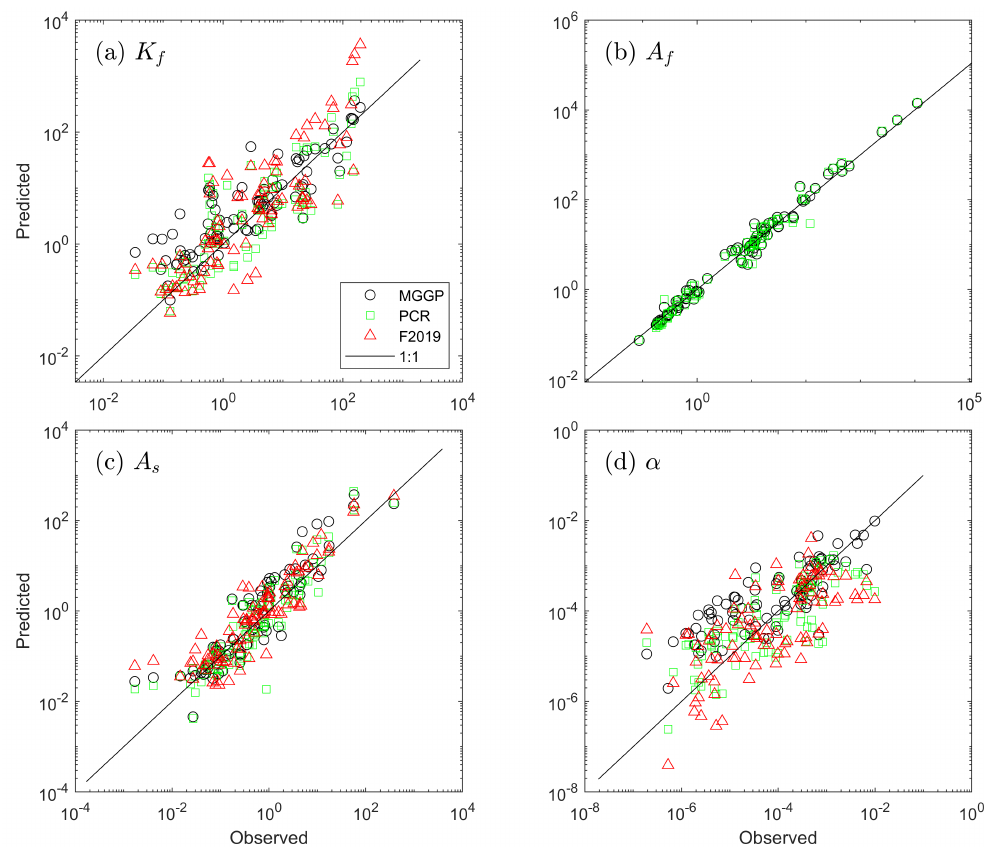
Figure 9. Observed parameter values versus predicted values by empirical equations for the training set; ( a ) K f . ( b ) A f . ( c ) A s . ( d ) α